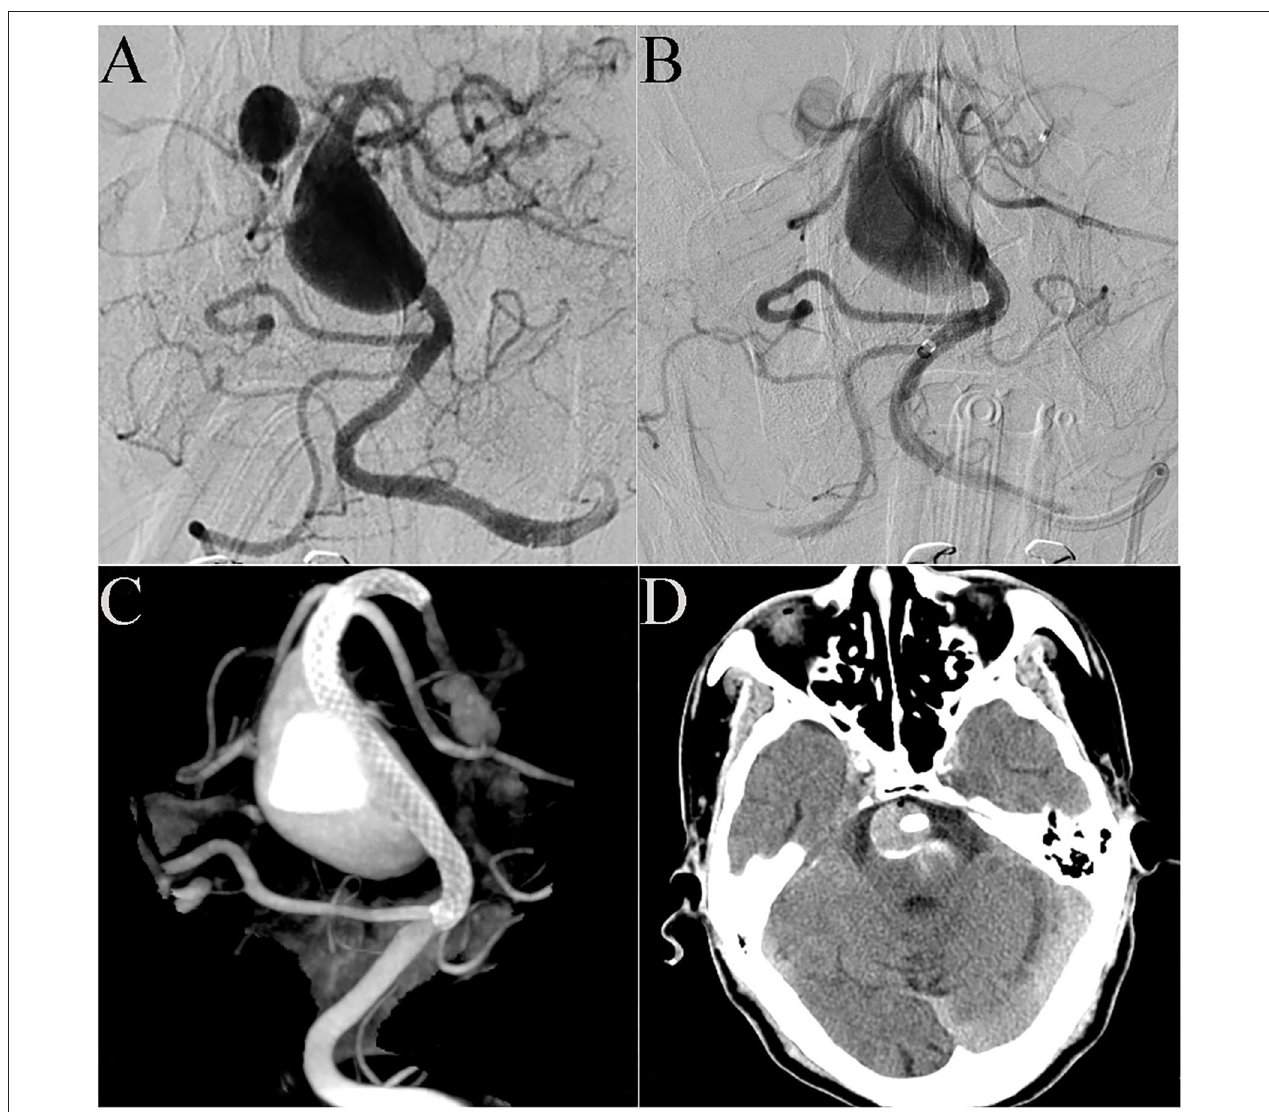
FIGURE 3 | Case 20: DSA showed that the patient had a giant dissecting aneurysm of the basilar artery and a posterior cerebral arterial aneurysm (A) . A 4.5mm × 35mm PED was successfully deployed in the basilar artery. Immediate post-embolization angiograms showed contrast stasis in the lumen of the aneurysm (B) . Dyna CT showed good vascular reconstruction (C) . Routine CT scanning showed no obvious bleeding or infarction on post-operative day 2 (D) .